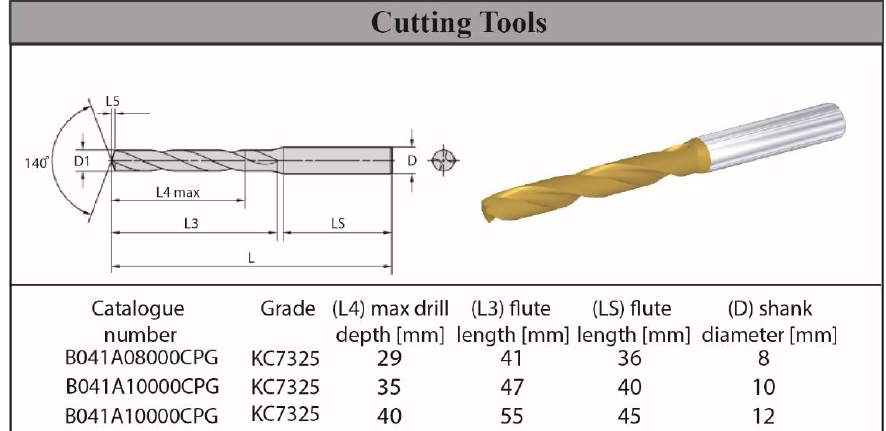
Figure 2. Cutting tool geometry details.